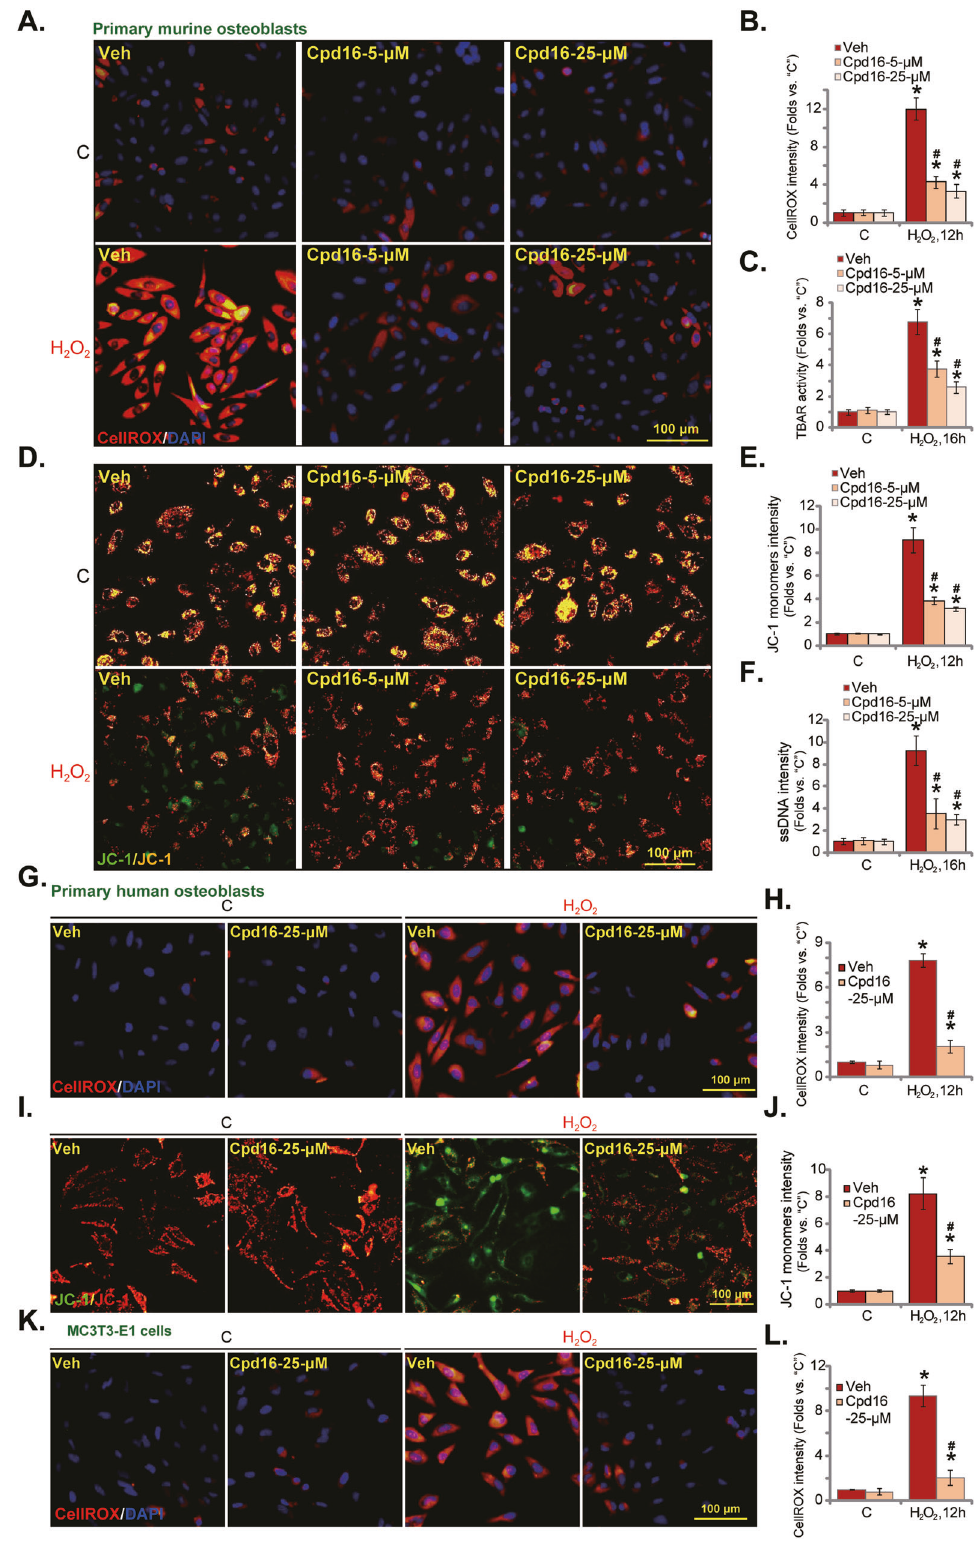
Fig. 2 Cpd16 ameliorates H 2 O 2 -provoked oxidative injury in osteoblasts. Primary murine osteoblasts ( A – F ), human osteoblasts ( G – J ), or the MC3T3-E1 murine osteoblastic cells ( K and L ) were pretreated (for 2 h) with Cpd16 (5/25 μ M), or plus H 2 O 2 (400 μ M) stimulation; ROS contents (the CellROX intensity assay, A , B , G , H , K , L ), TBAR activity ( C ), JC-1 dye staining ( D , E , I , J ), and ssDNA contents ( F ) were measured. * P < 0.05 “ Veh ” pretreatment. Scale bar = 100 μ versus “ C ” cells. # P < 0.05 versus cells with H 2 O 2 stimulation but